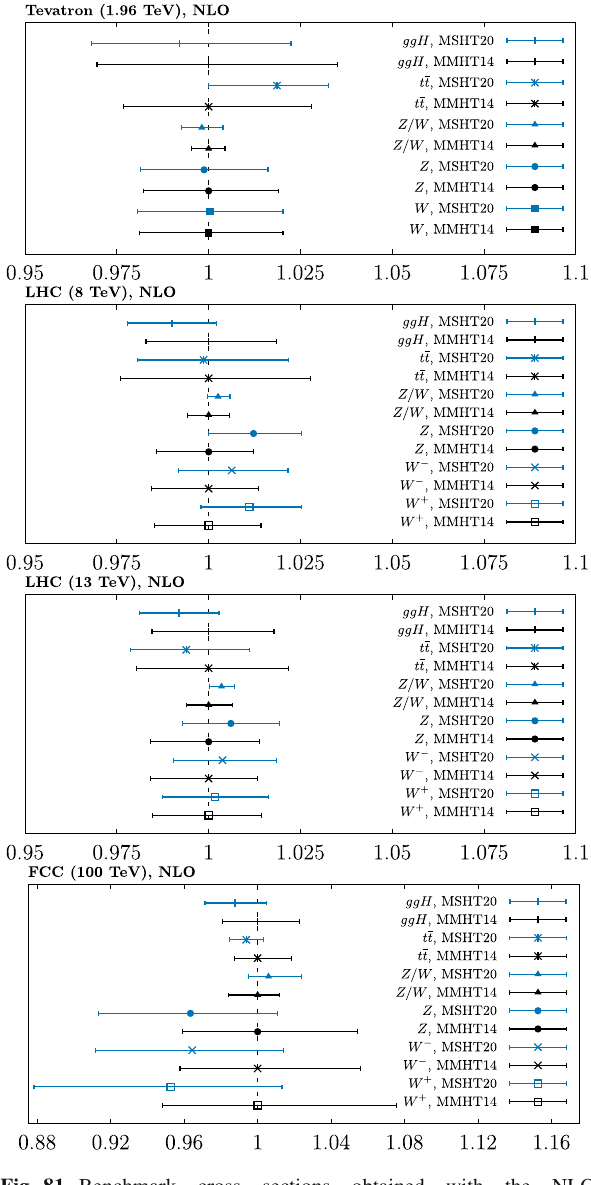
Fig. 81 Benchmark cross sections obtained with the NLO MMHT14 [1] and the NLO MSHT20 PDFs. Results are normal- ized to the central value of the MMHT14 prediction, and PDF uncertainties only are